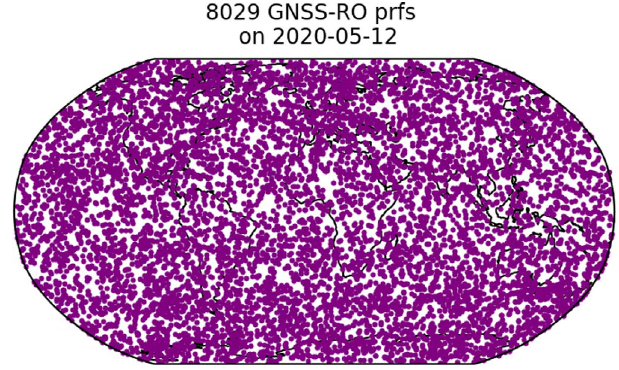
Fig. 1. Coverage map showing 8029 Spire GNSS-RO pro fi les collected on 12